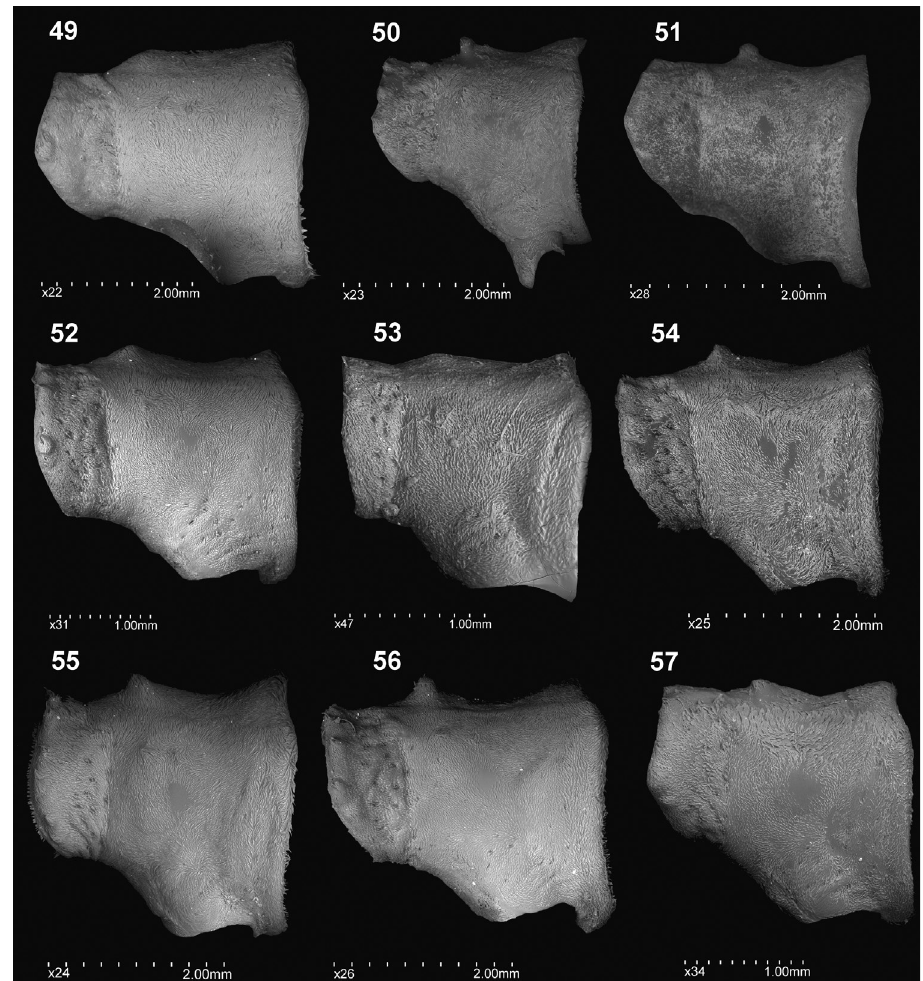
Figures 49–57. Pronotum, lateral view: 49 C. farinosus Perr. 50 C. fundatus sp. n. 51 C. gibbus sp. n. 52 C. malleus sp. n. 53 C. minimus sp. n. 54 C. rutai sp. n. 55 C. szoltysi sp. n. 56 C. torosus sp. n. 57 C. turbidus sp. n.